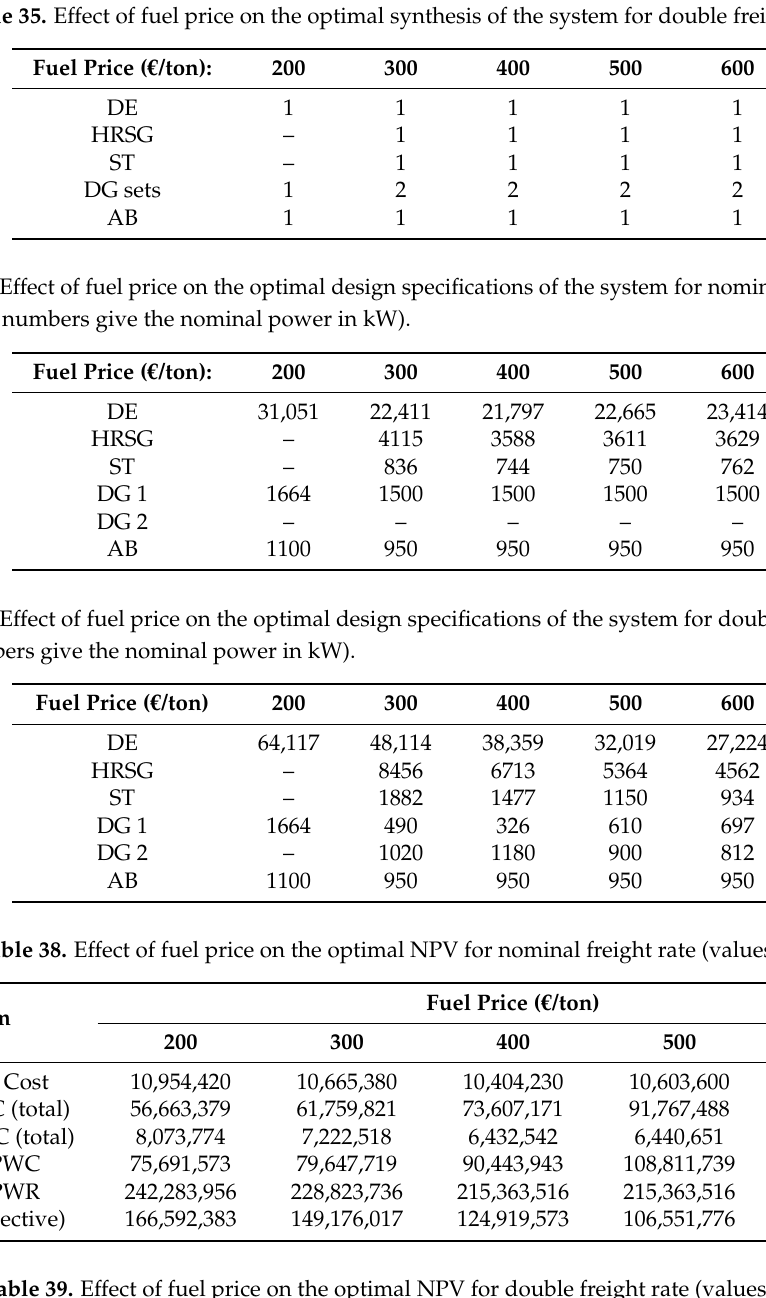
Table 39. Effect of fuel price on the optimal NPV for double freight rate (values in €